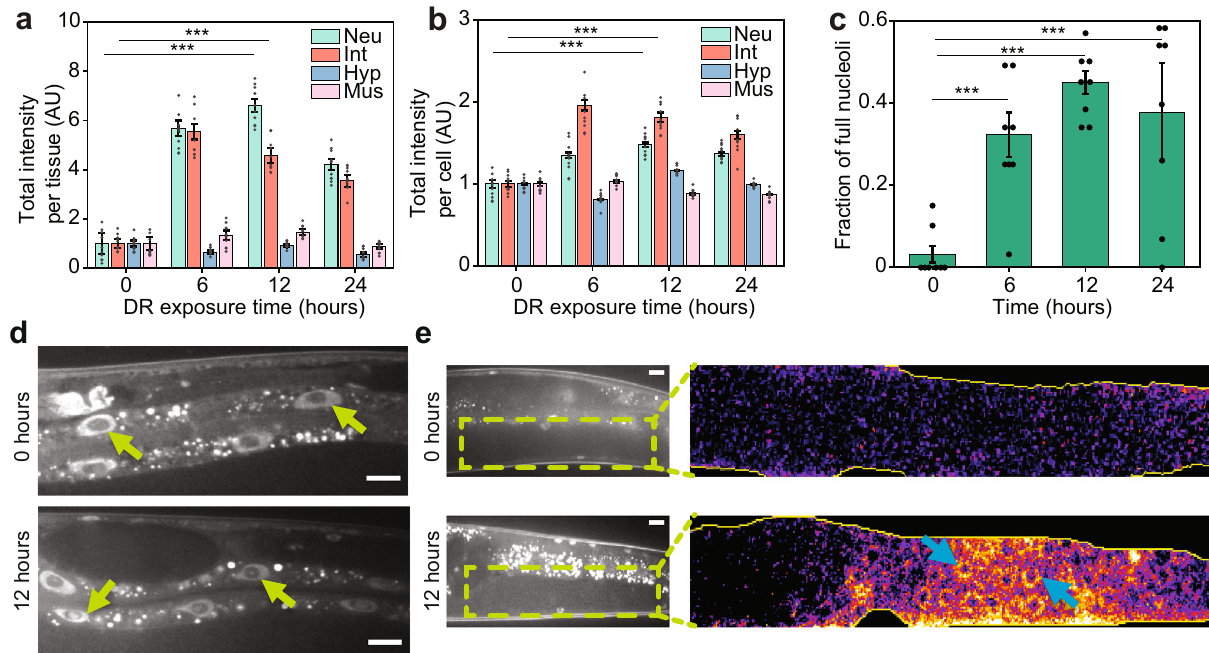
Fig. 4 Tissue-speci fi c analysis of DAF-16 reveals crucial role of intestine cells and neurons, nucleolar accumulation, and germline localization under liquid culture DR. a DAF-16 normalized total intensity as a function of exposure time for various tissues. Neuron and intestine cells show the largest contribution to DAF-16 total intensity compared to hypodermis and muscle cells at a 10 8 OP50 cells/ml food concentration. b DAF-16 total intensity per cell as a function of exposure time for various tissues at a 10 8 OP50 cells/ml food concentration. c Fraction of intestinal nucleoli showing DAF-16 presence as a function of exposure times at a 10 8 OP50 cells/ml food concentration. d Examples of animals with empty nucleoli (0 h) and DAF-16 in the nucleoli (12 h) at a 10 8 OP50 cells/ml food concentration. e Inset highlights the gonad of a well-fed animal (0 h) and one exposed to a food concentration of 10 8 cells/ml (12 h). DAF-16 in the germline can be discerned in the DR-exposed animal (light-blue arrows). Error bars are SEM. p < 0.001 (***). All p -values were calculated using Tukey HSD for all pairwise comparisons after one-way ANOVA (unequal variances) comparison. Scale bars are 20 µ